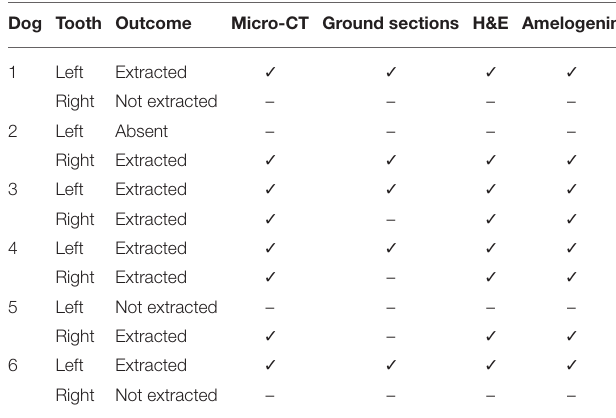
TABLE 3 | Summary of investigations performed on 8 extracted mandibular first molar teeth with developmental abnormalities. Dog Tooth